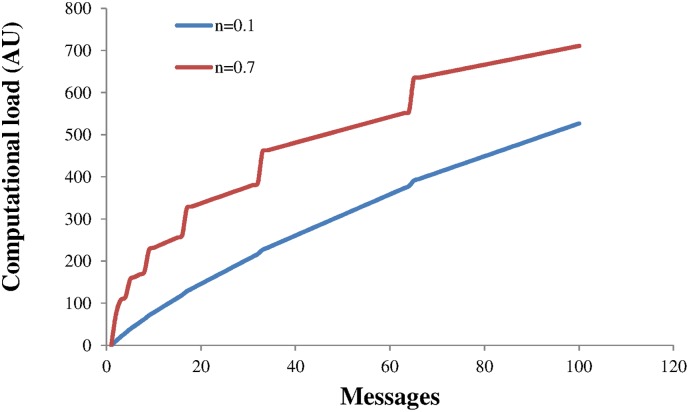
The computational load for modest and high noise levels.